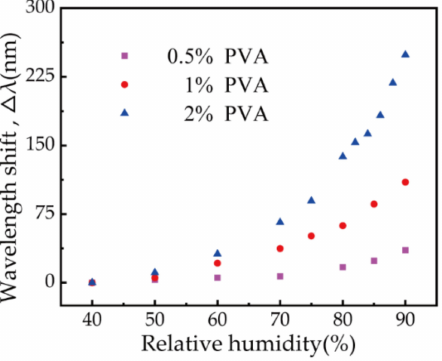
Figure 5. Resonant wavelength shift for samples 1 (0.5% PVA), 2 (1% PVA), and 3 (2% PVA) with increasing